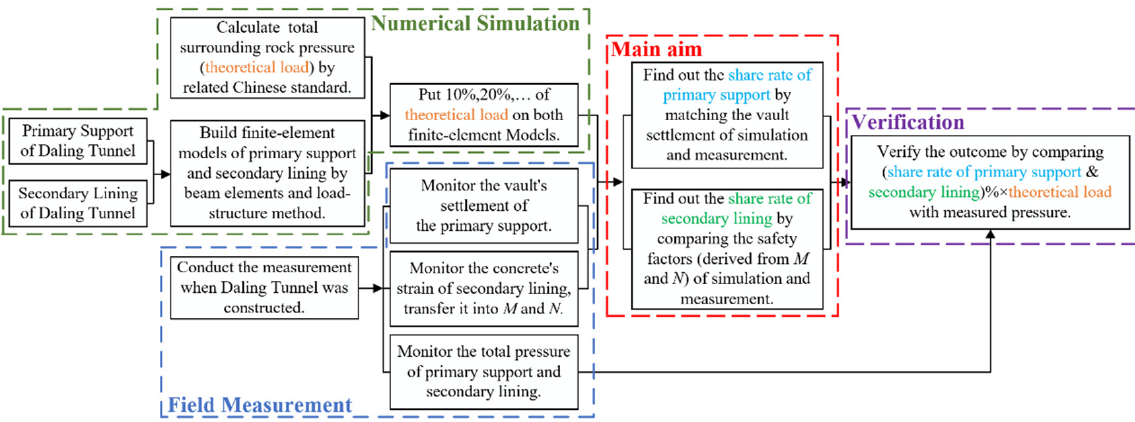
Figure 1. The process of this research. Numerical simulation and field measurement are combined to find out the share rates of primary support and secondary lining. Verification is proposed in final phase.